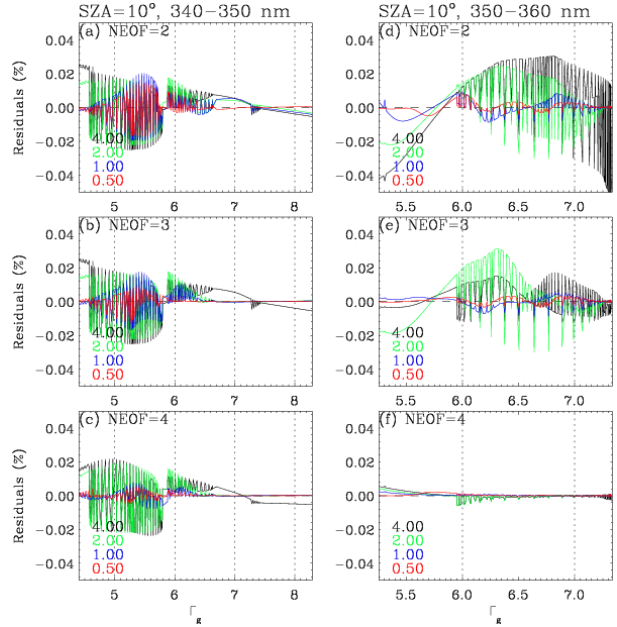
Figure 5. Same as Fig. 4 but for different windows: (a, b, c) 340– 350nm and (d, e, f) 350–360nm, respectively.